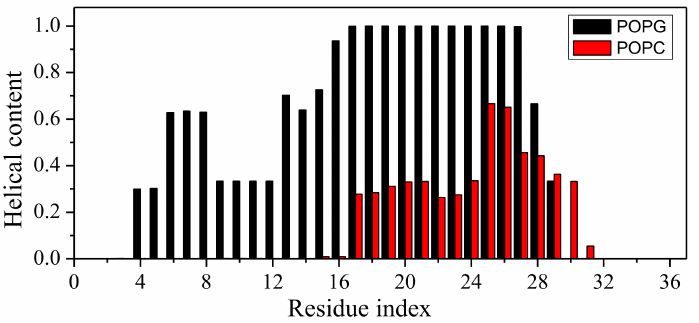
Figure 4. Helical contents of LL-37 at different sequence positions in the last 100 ns conformational ensemble of LL-37/POPG and LL-37/POPC systems. The helical content is defined as the fraction of conformations of a residue in helix in all